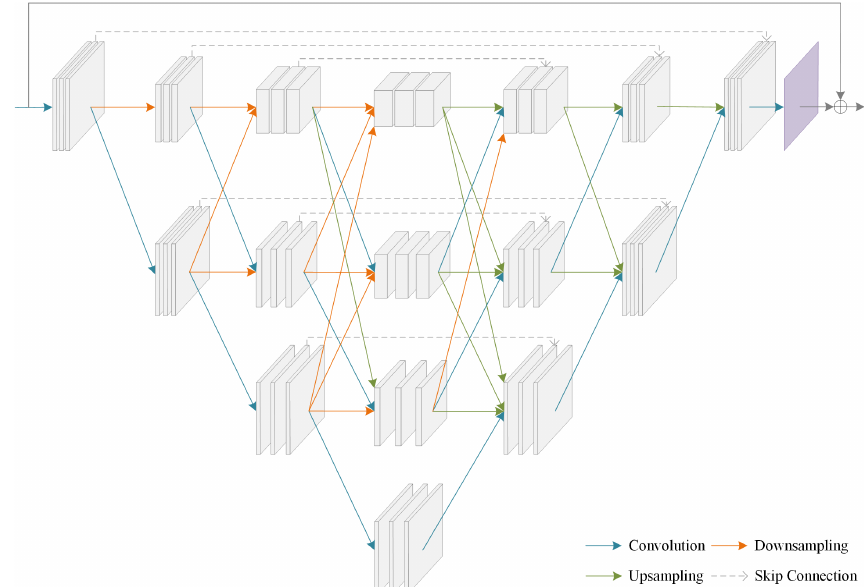
Figure 2. The architecture of MPI-net.